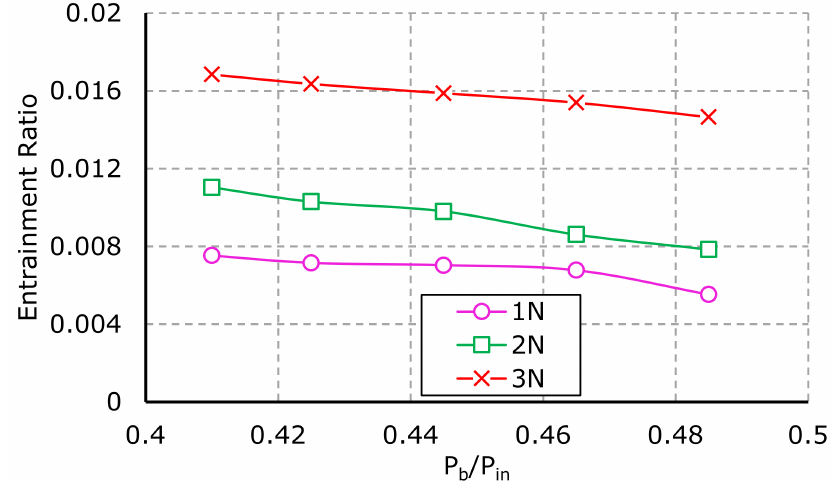
Figure 12. E r at different outlet conditions (P b /P in ).